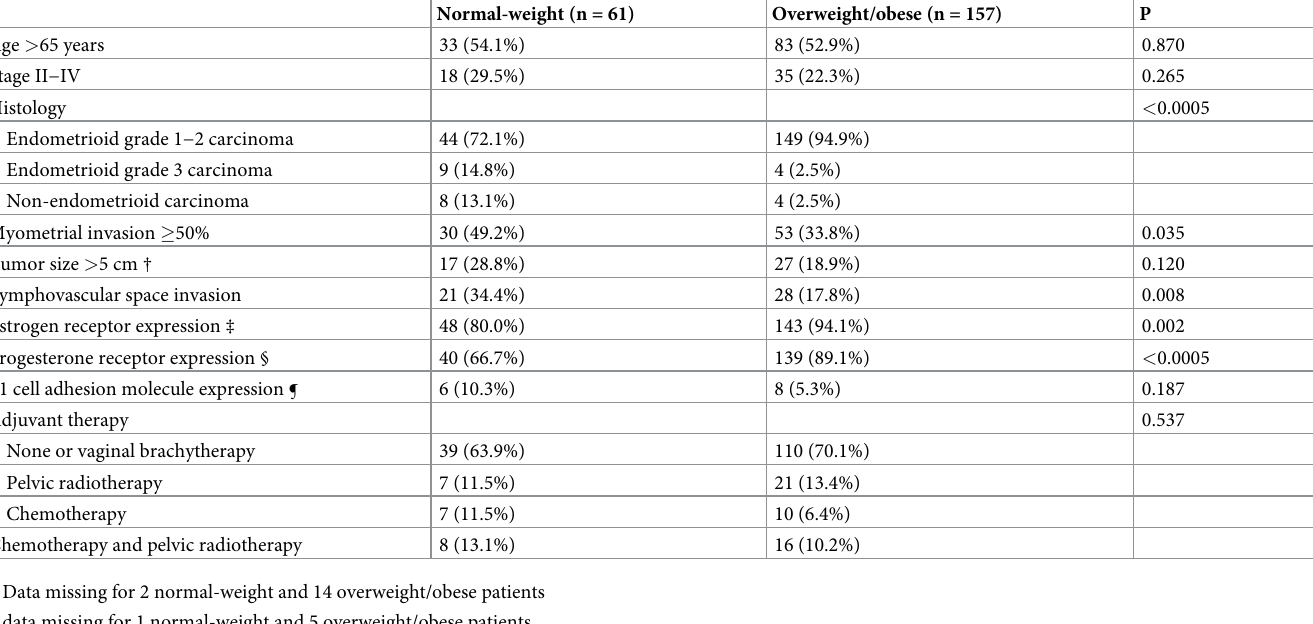
Table 3. Proportions of various prognostic variables in normal-weight and overweight/obese patients with “no specific molecular profile” subtype endometrial cancer. Normal-weight (n =